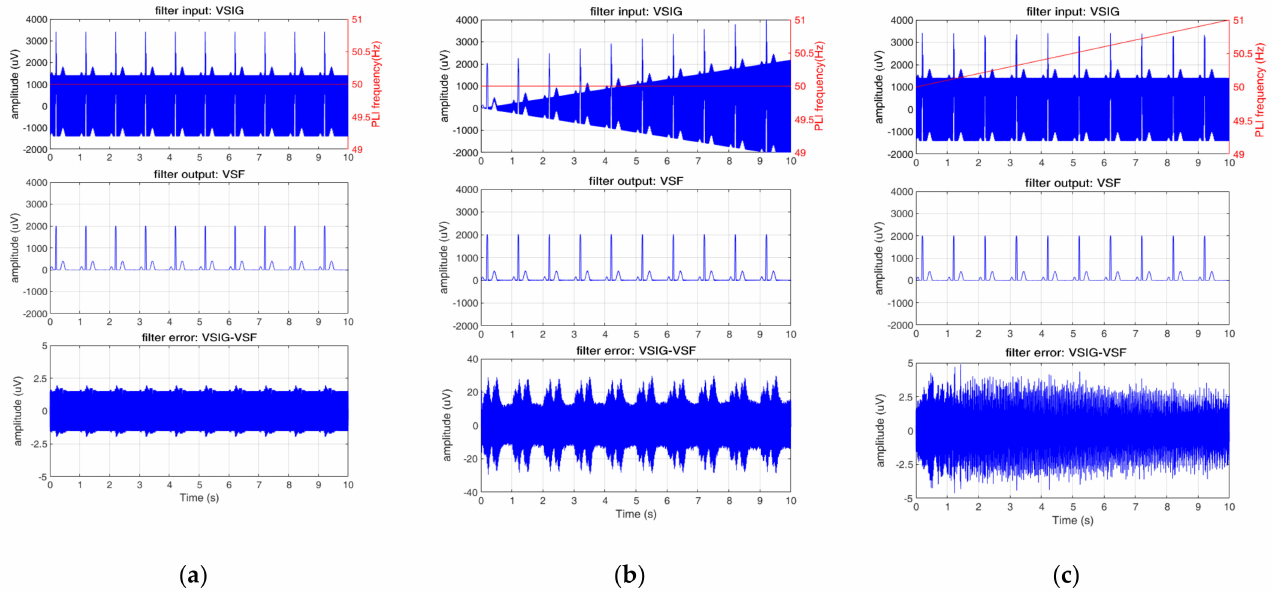
Figure 8. Performance of the SF algorithm with the optimal setting k i = 2 − 21 for an ECG example record (CAL20100 from CTS ECG dataset). The filter input (first trace), filter output (second trace), and filter error (third trace) are computed for three PLI settings in Table 1: ( a ) PLI constant, ( b ) PLI linear amplitude change, ( c ) PLI linear frequency